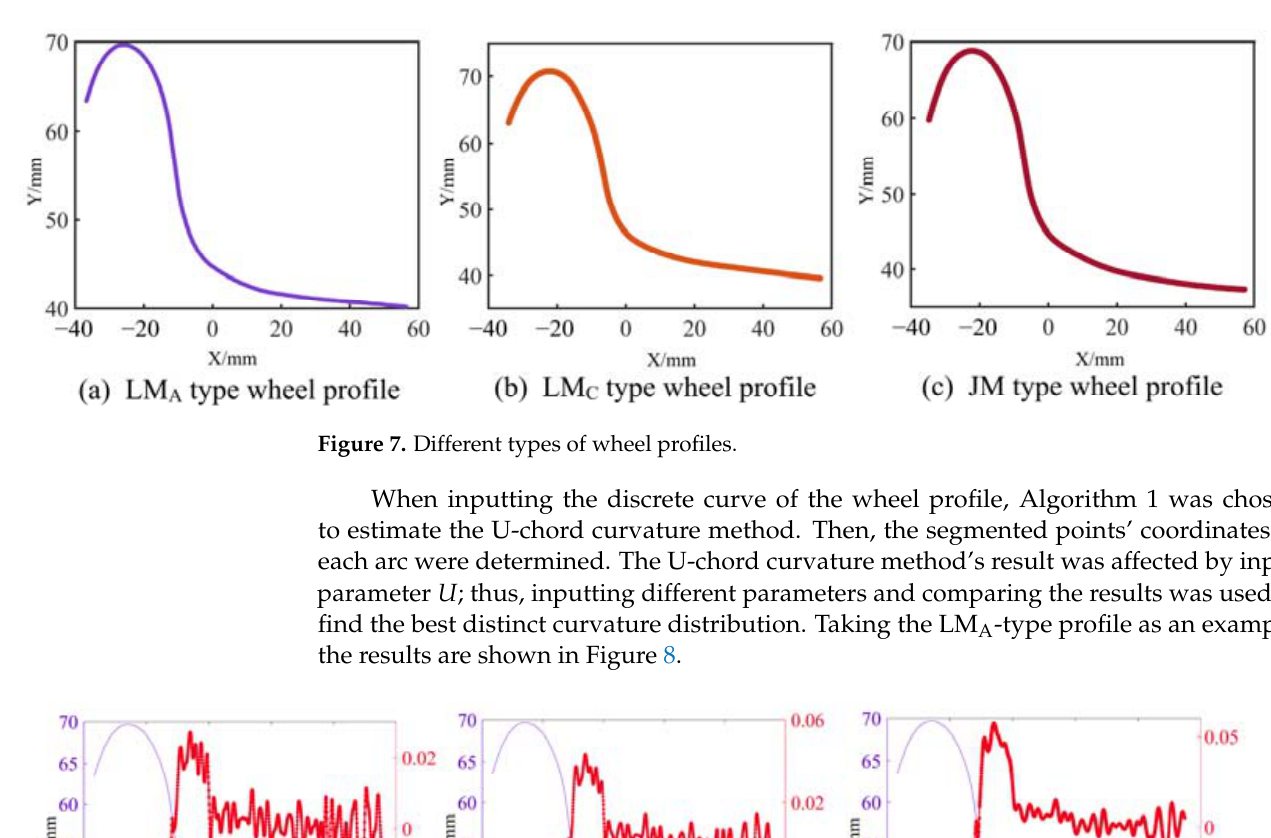
11 of 24 Figure 6. Using laser profile sensor to scan the wheel profile. Table 1. The key performance parameters of the laser sensor. Parameters